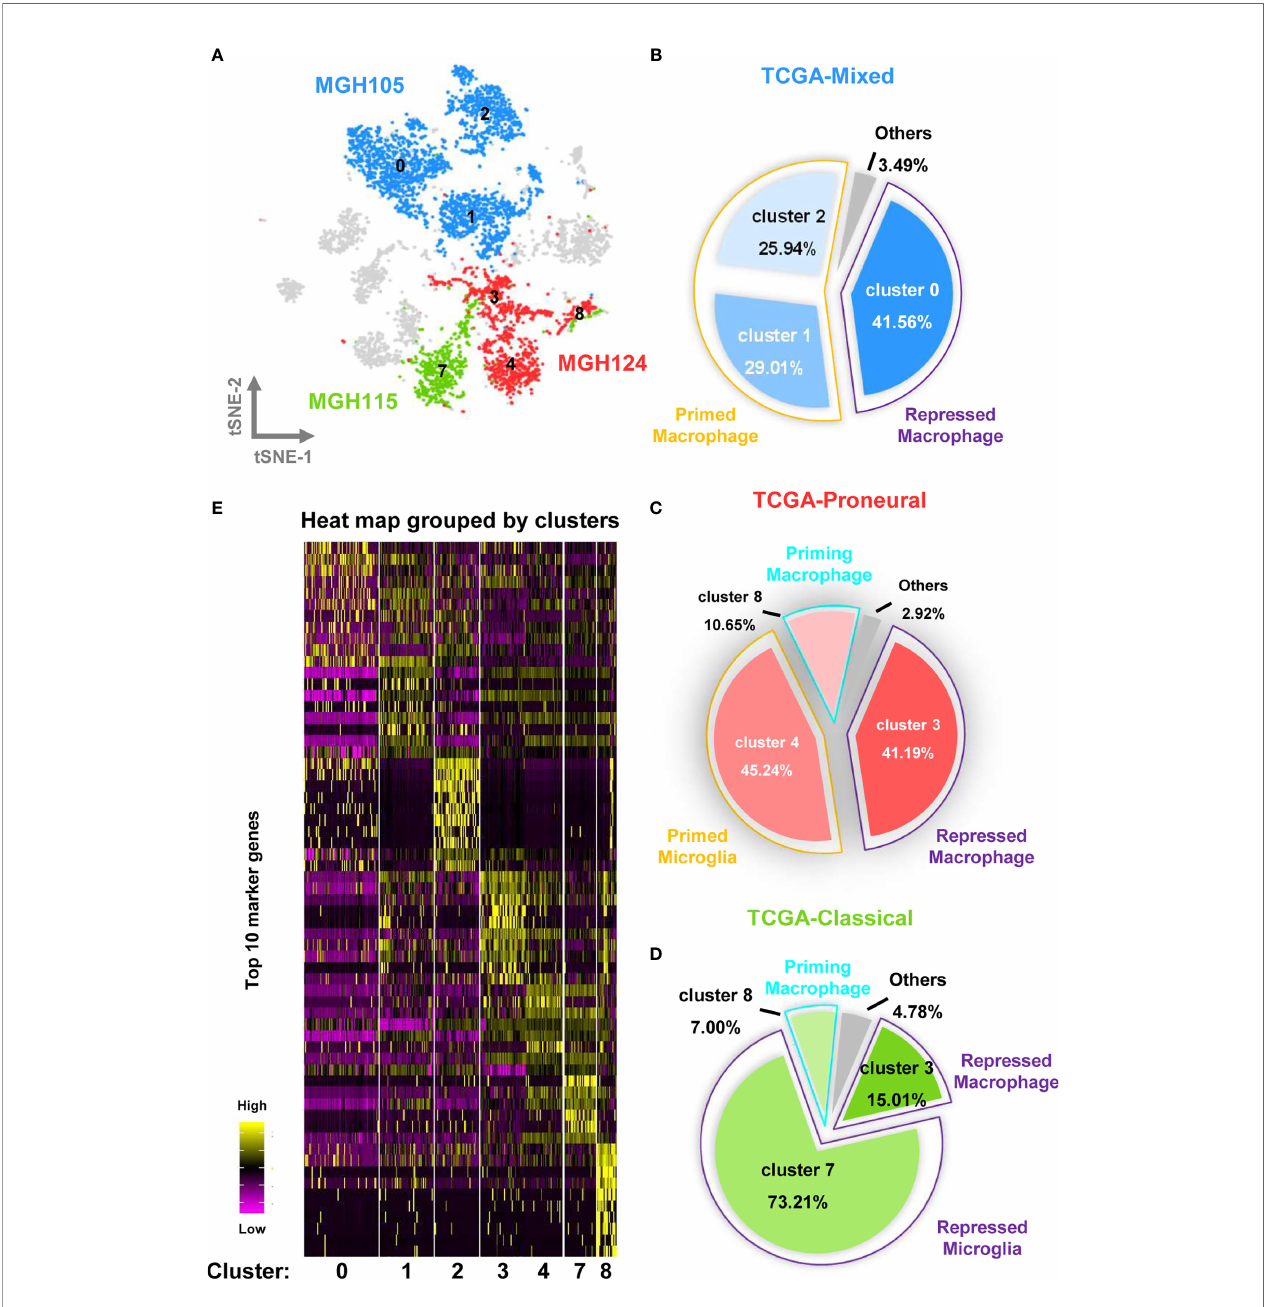
FIGURE 3 | Different molecular subtypes of GBM have distinct TAM composition and characteristics. (A) The cell distribution of MGH105, MGH115, and MGH124 are shown by the t-SNE plot. (B) TAMs in the TCGA-mixed tumor comprise repressed macrophages, primed macrophages, and others. (C) TAMs in the TCGA- proneural tumor comprise repressed macrophage, primed microglia, priming macrophages, and others. (D) TAMs in the TCGA-classical tumor contain repressed macrophages, repressed microglia, priming macrophages, and others. (E) The expression pro fi les of the top 10 marker genes of each cluster are displayed as a heat